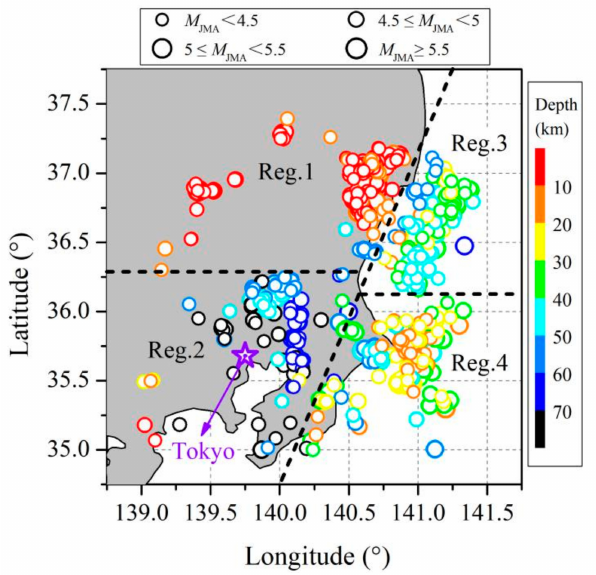
Figure 1. The location, magnitude, and focal depth of 881 earthquakes that occurred in the range of 139–141.5 ◦ E, 35–37.5 ◦ N from 1 January 2010 to 31 December 2019. The circles indicate the location of the earthquake, with different colors and sizes distinguishing the source depth and magnitude. The black dashed lines represent the approximate division of the source location region, which roughly divides the research scope into regions—Reg.1, Reg.2, Reg.3, and